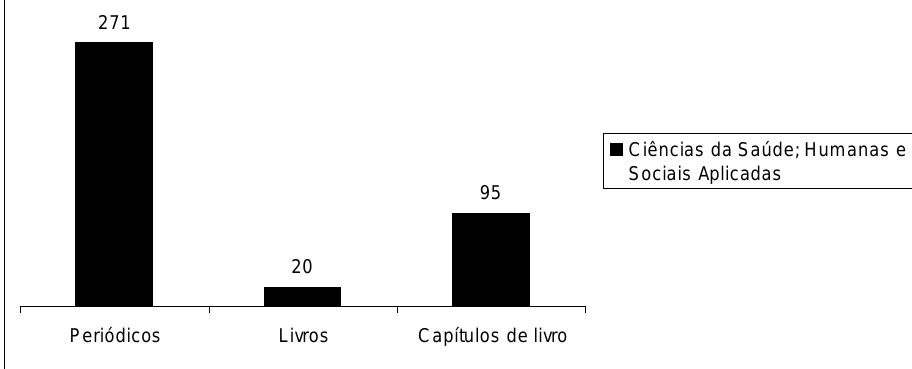
Figura 12. Distribuição da produção científica total dos 23 grupos de